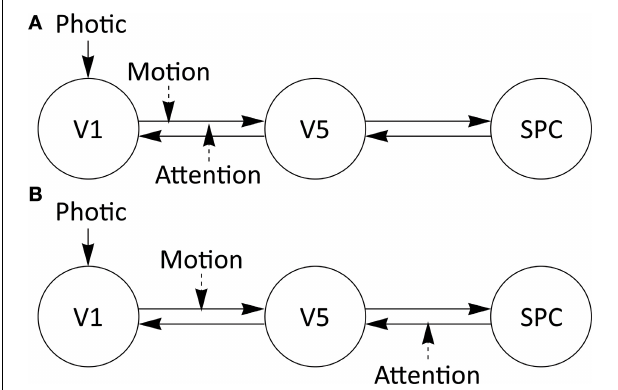
FIGURE 1 | Three-region models specified for the attention to visual motion dataset. Driving and modulatory inputs are denoted by Photic and Motion and Attention, respectively. V1, primary visual cortex; V5, extrastriate visual area V5; SPC, superior parietal cortex. (A) Attention to motion DCM with experimental modulations on one forward connection (“forward model”) from V1 to V5. (B) Attention to motion DCM with experimental modulations on one forward and one backward connection (“backward model”), V1 to V5 and SPC to V5, respectively. For subsequent parameter assessments, the DCM-estimates from the original single-subject dataset were